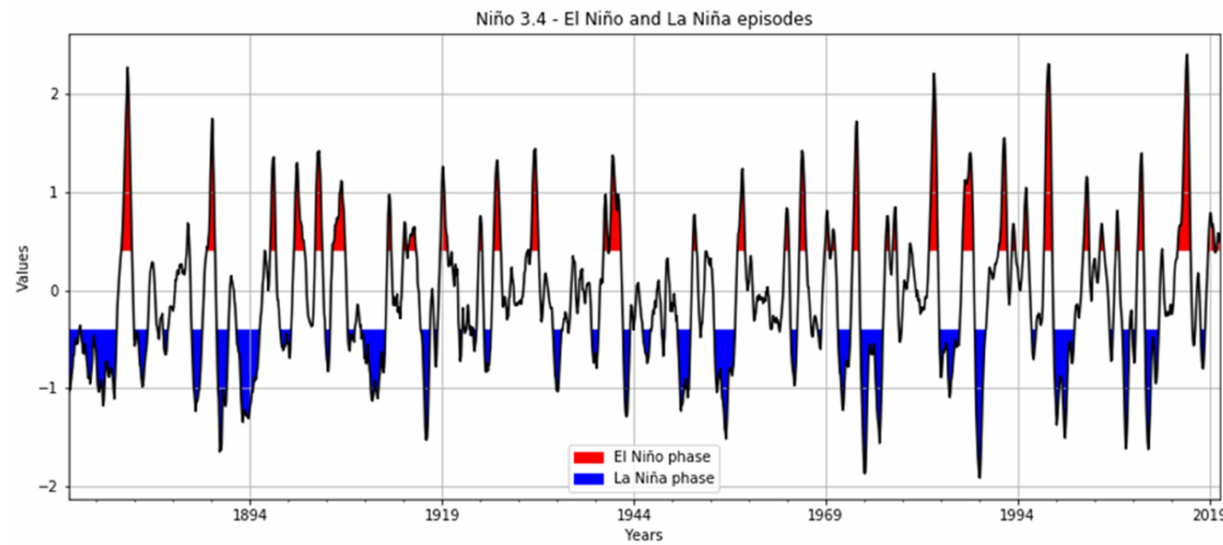
Figure 2. Time series of El Niño and La Niña episodes, with at least five consecutive overlapping three-month seasons with Oceanic Niño Index (ONI) ≥ + 0.5 ◦ C or ONI ≤ − 0.5 ◦ C, respectively. The basic time series corresponds to the Niño 3.4 record.